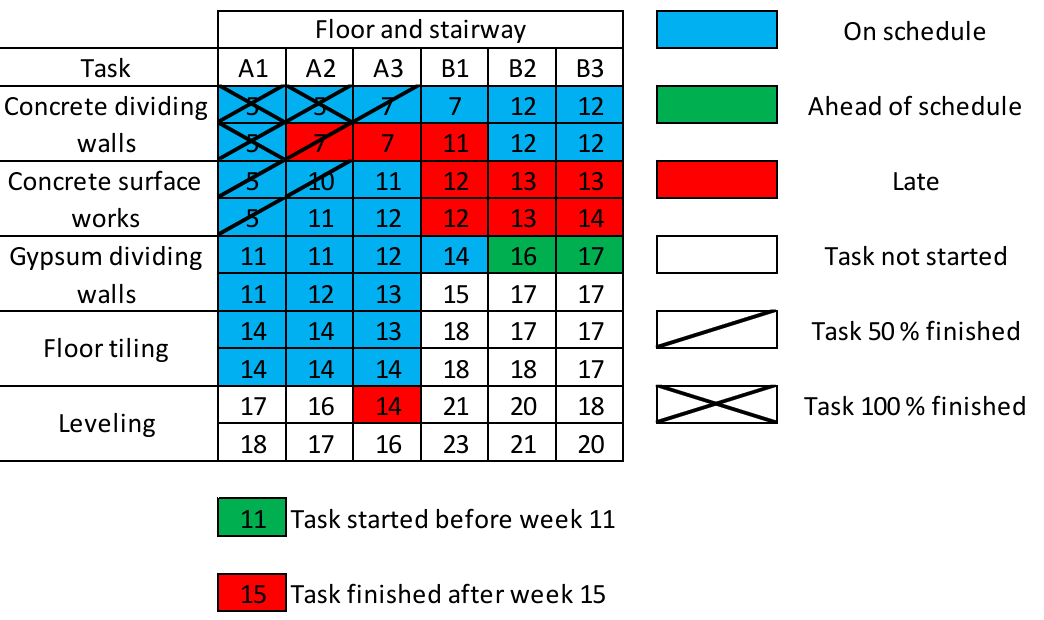
Figure 1. An example of a vignette used in site monitoring [9].